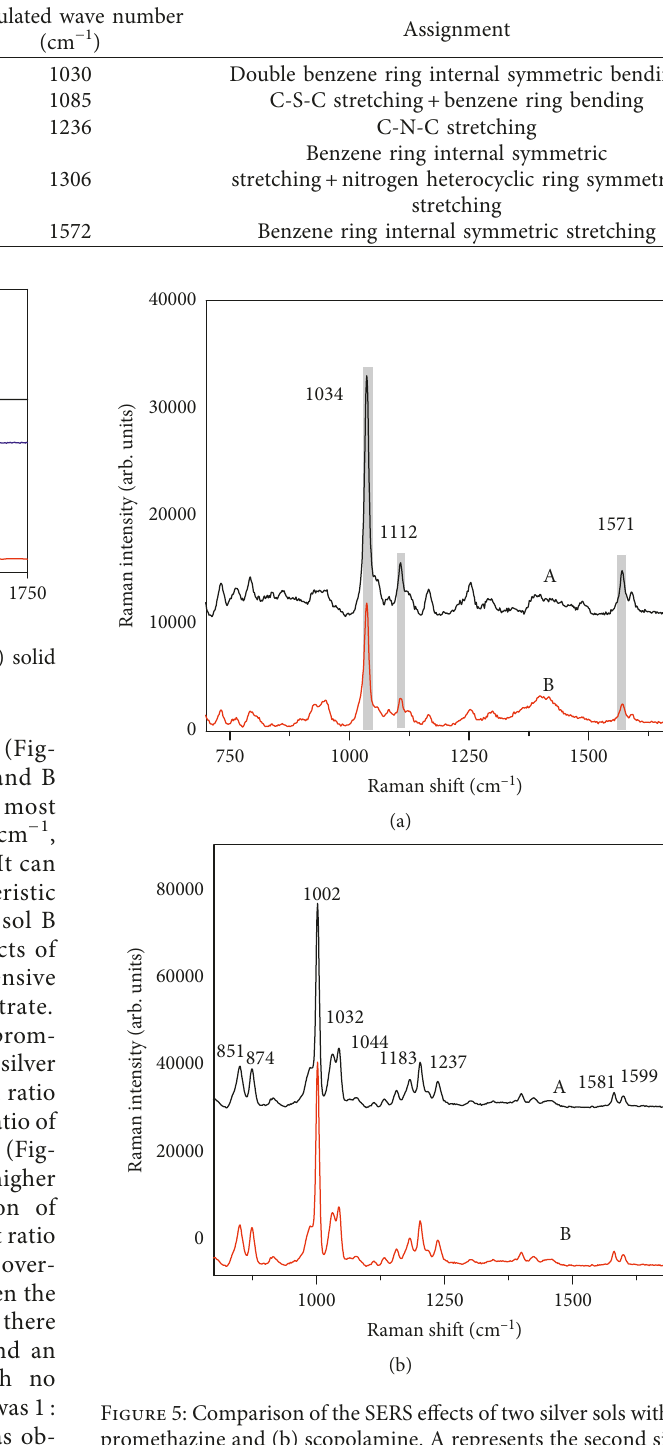
Table 1: Assignment of the Raman characteristic peaks of promethazine.